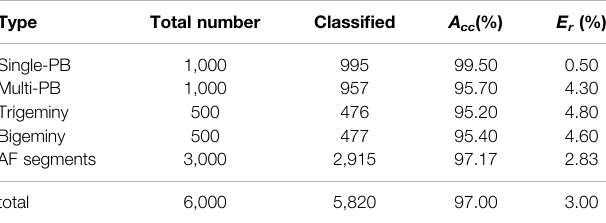
TABLE 1 | Result of ECG segments with four different kinds of premature